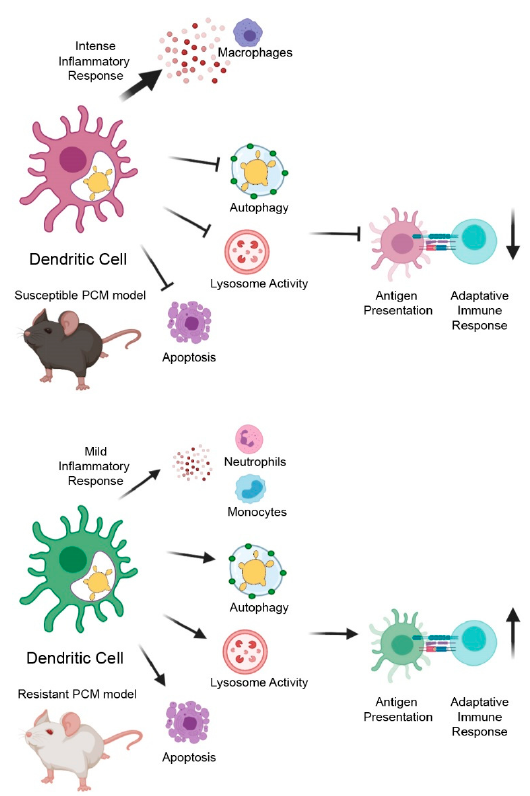
Figure 8. Schematic model of major transcriptional differences of BMDCs from resistant (A/J) and susceptible (B10.A) mouse strains upon infection with P. brasiliensis . BMDCs from the susceptible strain displayed a more intense activation of inflammatory response followed by the downregulation of autophagy, lysosome activity, and apoptosis, all processes involved in antigen processing and presentation and the activation of adaptive immune response. In contrast, BMDCs from the resistant mouse induce a mild inflammatory response with preserved functionality of autophagy, lysosome activation, and apoptosis, which might lead to more e ffi cient antigen processing and presentation and proper activation of adaptative immune